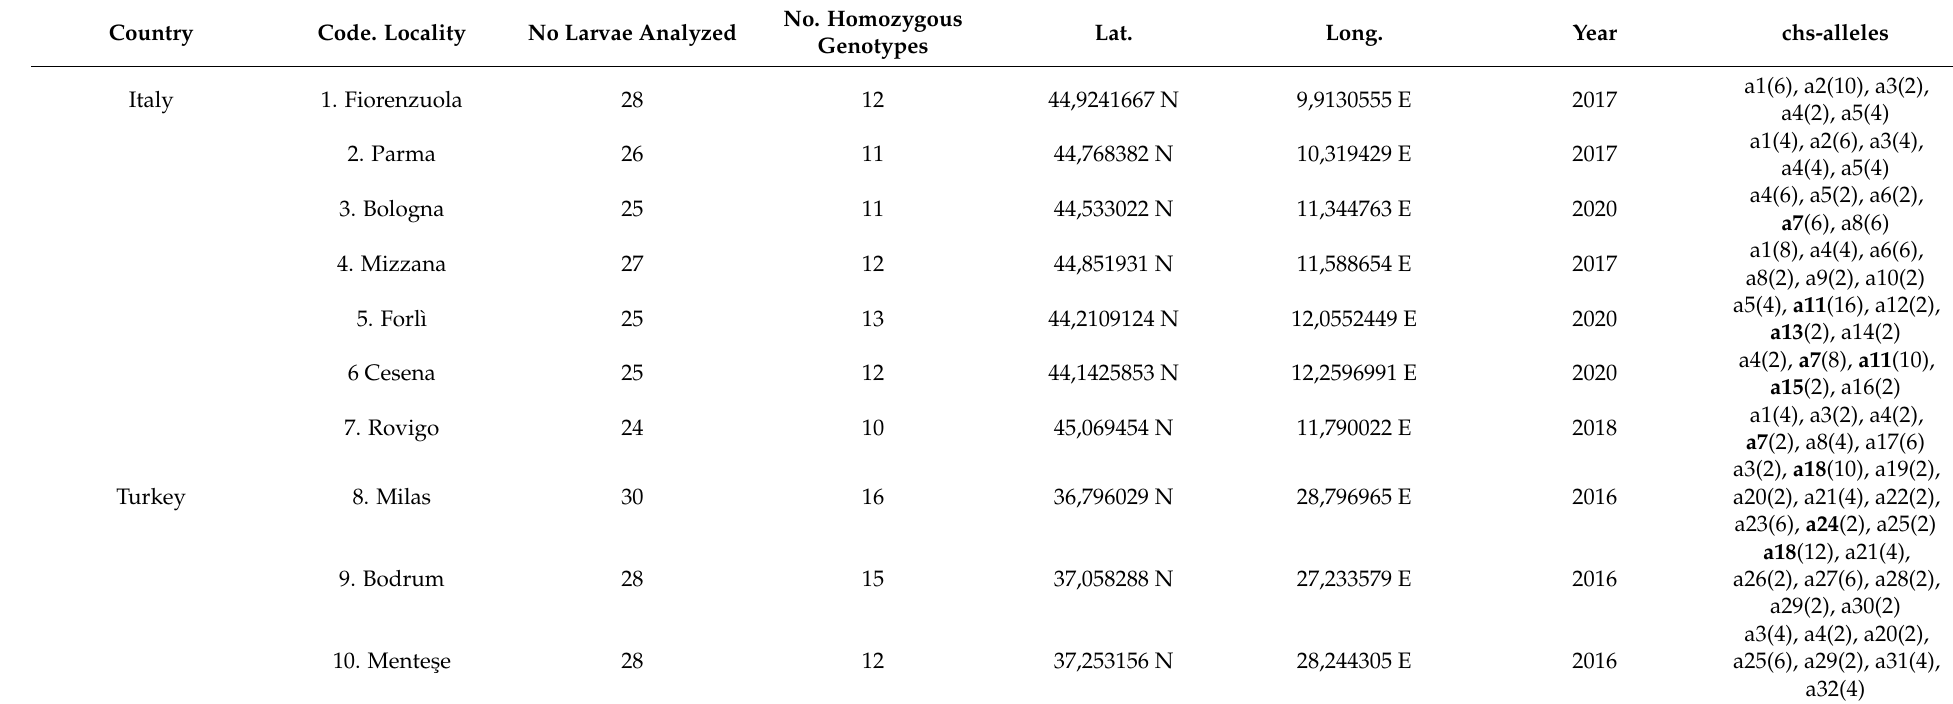
Table 1. Locations, year of collection of the Culex pipiens samples analyzed in this study and number of homozygous sequences found in each locality. In brackets how many times a chs-allele was found in the population is shown. The chs-alleles that carry the DFB-resistant mutations are shown in bold: a7 (I1043L mutation); a11 and a18 (I1043M mutation); a13, a15, and a24 (I1043F